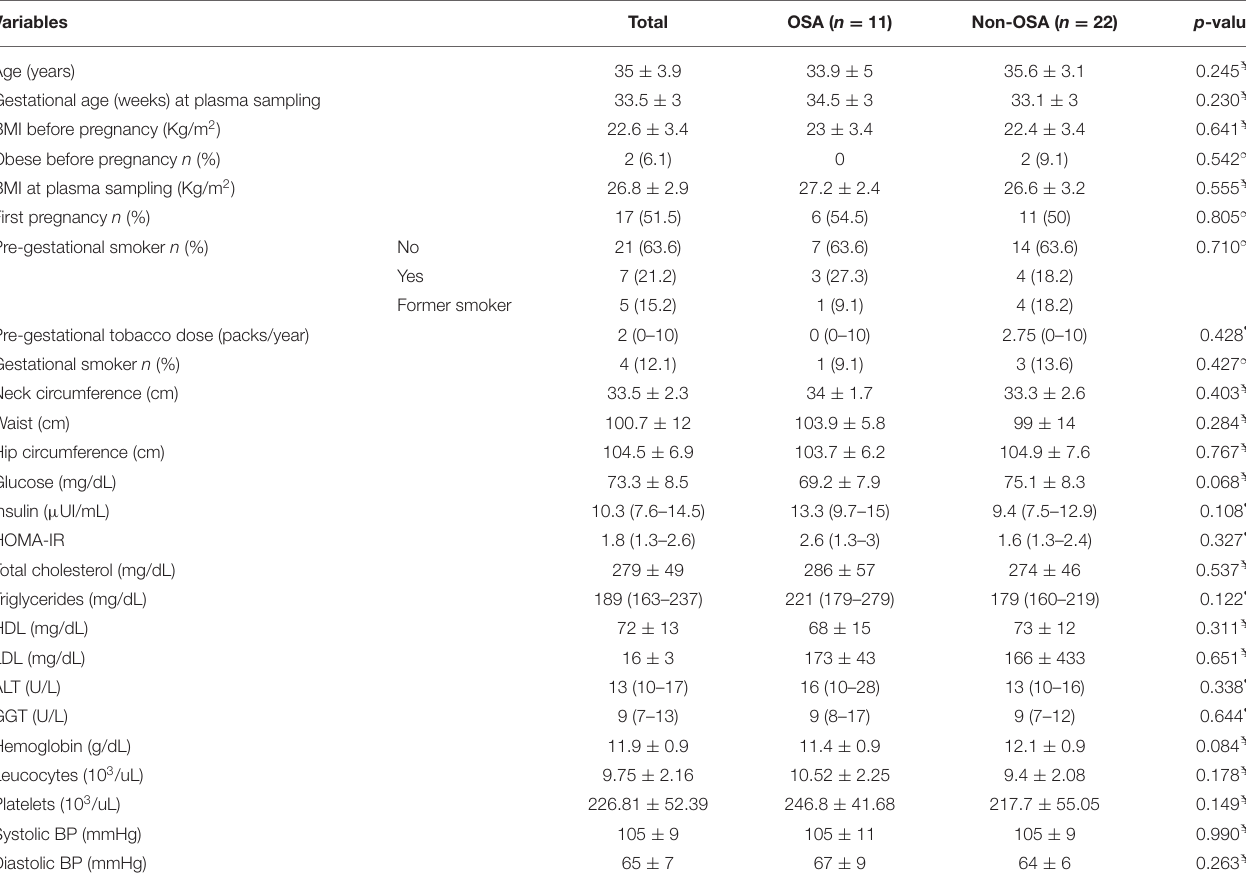
TABLE 1 | General characteristics of pregnancy women with and without OSA.